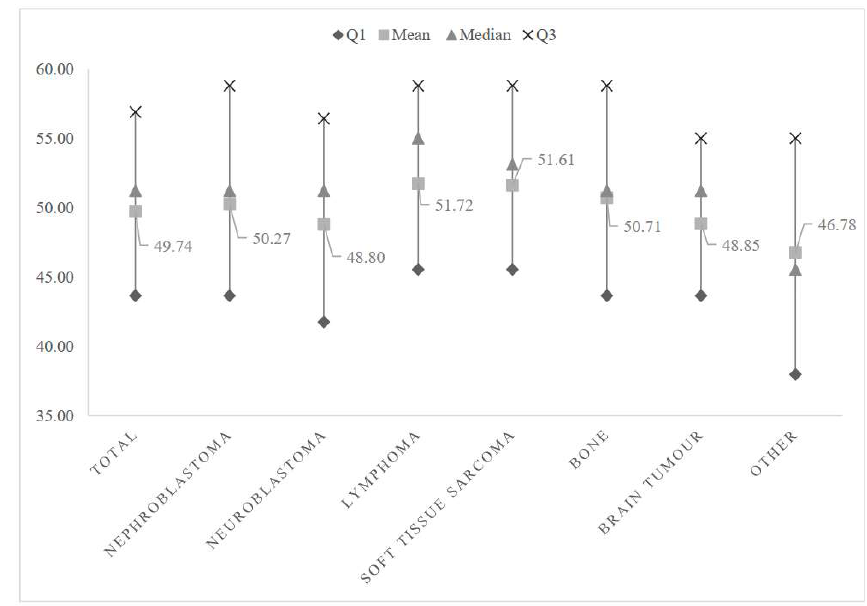
Figure 1. Mental Health Inventory-5 (MHI-5) score by cancer type. Table 3. Variables and factors associated with the Mental Health Inventory-5 (MHI-5) score.